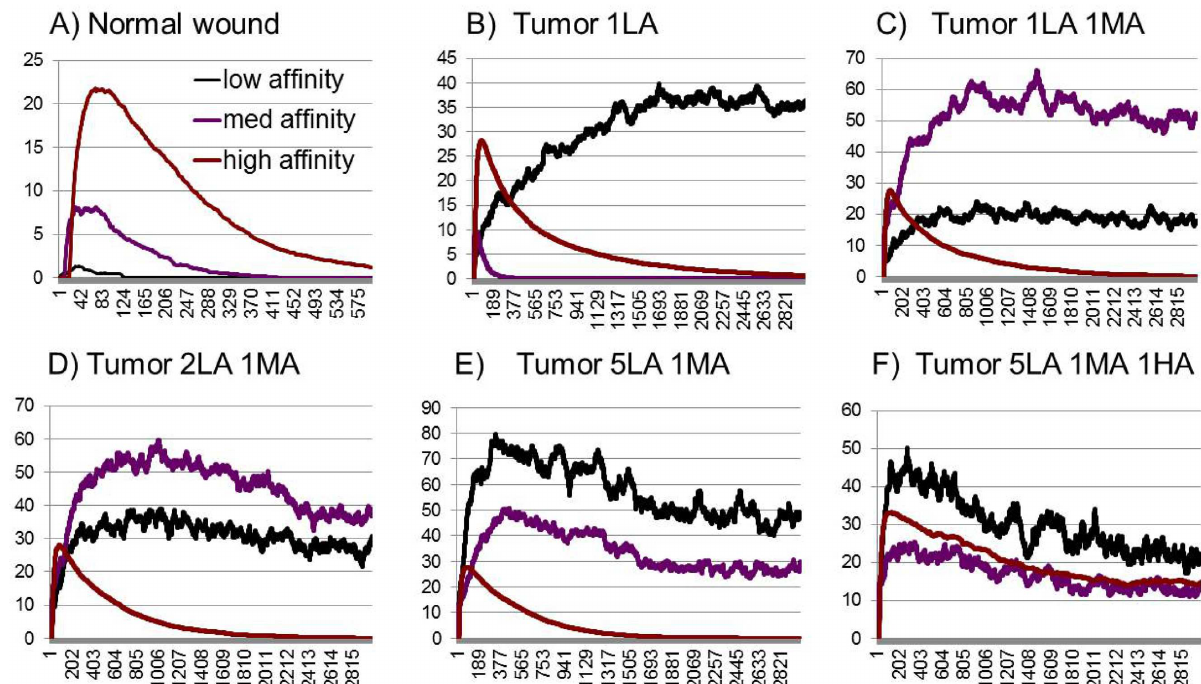
Fig 4. Summaryof simulations for normal and pathological angiogenesis. The simulationof cytokine profiles in normal woundhealing (A) is distinctly different from the cytokine profiles duringtumor angiogenesis(B-F). In order to simulate tumor angiogenesis, a number of scenarioswere explored: The release of 1 additional low affinity cytokine releasedinto the model microenvironment per run (B); 1 additional low affinity (LA) and 1 medium affinity (MA) (C); 2 LA and1MA (D); 5LA and 1MA (E); and 5LA, 1MA and 1HA (F). The combination of continuouspresenceof LA and MA may be suggestiveof continuedformation of new, but leaky